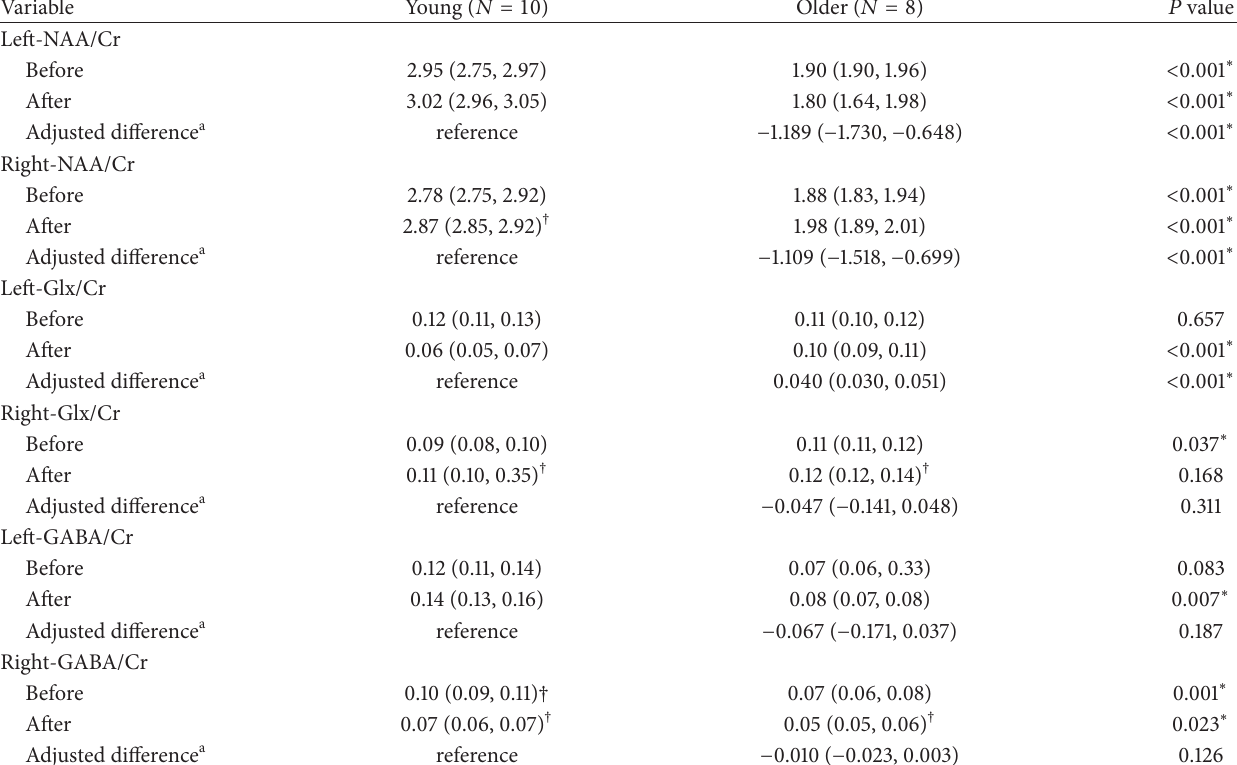
Table 1: Comparison of central auditory function between the young and older groups before and after pure tone